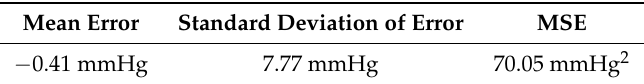
Table 3. Blood pressure estimation (BPE) approach after Cattivelli et al. [30]: performance measures applied in the original publication evaluating the systolic blood pressure (SBP) estimation routine. Diastolic blood pressure (DBP) estimation is not considered in this